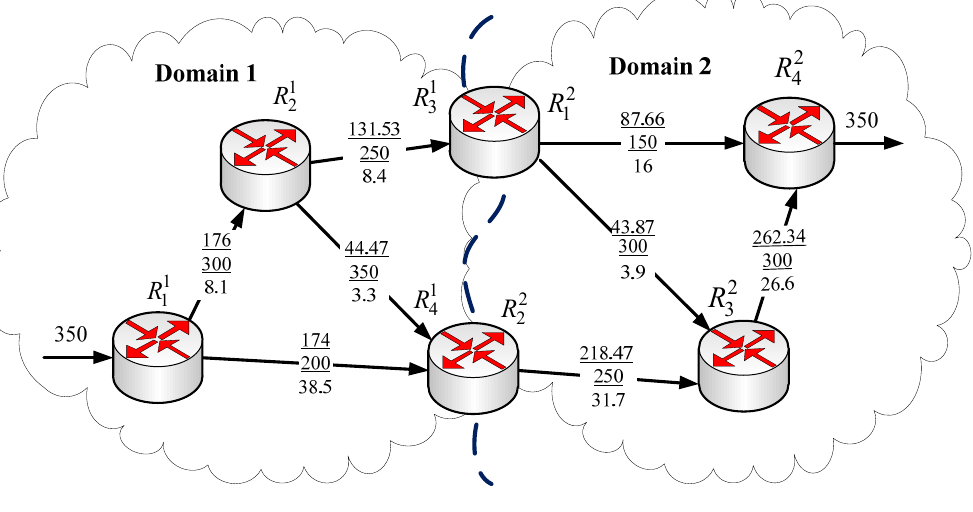
Figure 7. Final (coordinated) solution of inter-domain QoS routing problem (after the third iteration of the coordination procedure) following the normalized requirements (23).